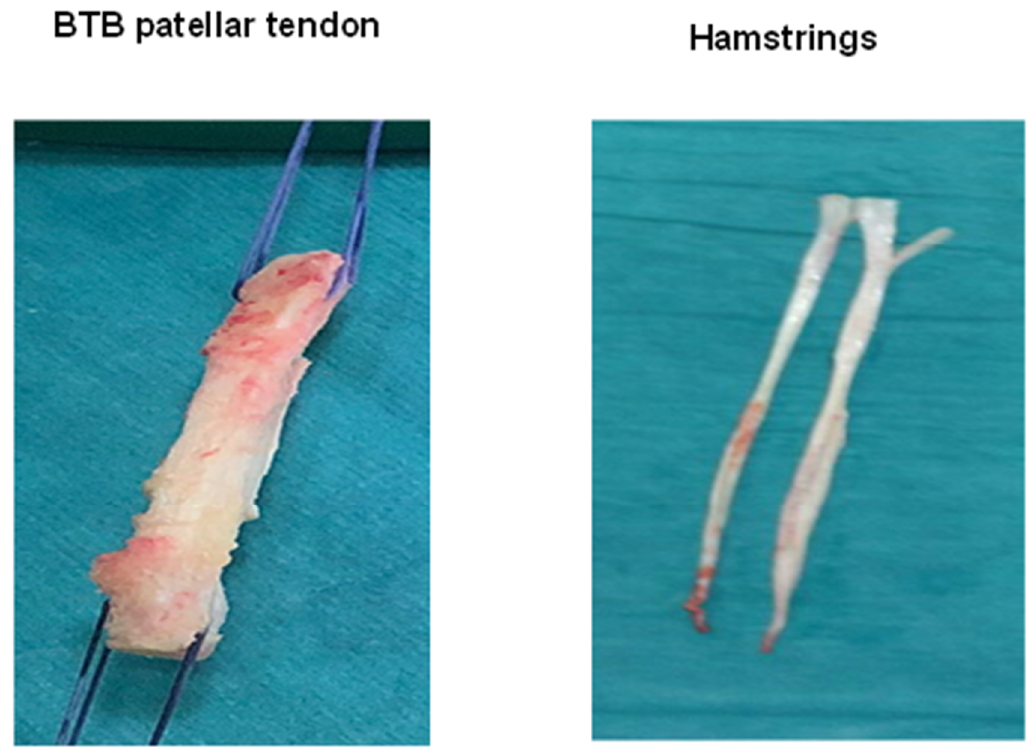
Figure 1. Types of tendon autografts for anterior cruciate ligament reconstruction (ACLR): bone-tendon-bone (BTB) patellar tendon autograft ( left ); hamstrings autograft ( right ).